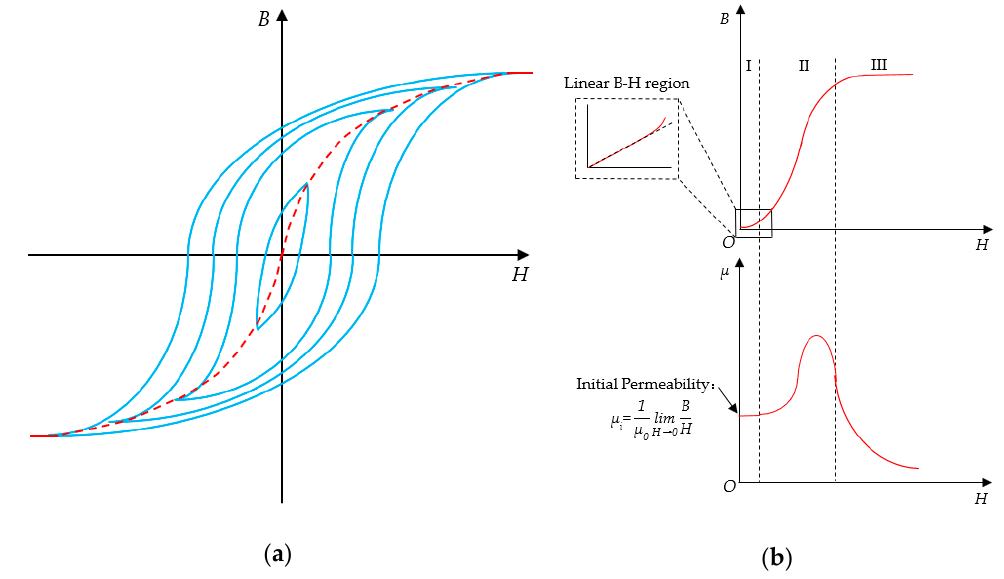
Figure 5. Magnetic characteristic curves: ( a ) high-frequency magnetization curves; ( b ) initial magnetization curve.